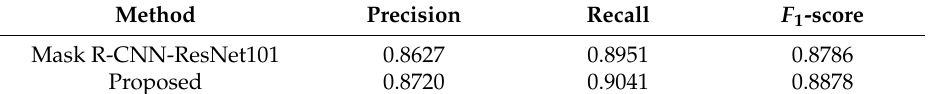
Table 2. Comparisons of the proposed method and Mask R-CNN-ResNet101 on the Fujian Dataset in terms of precession, recall, and F 1 -score.